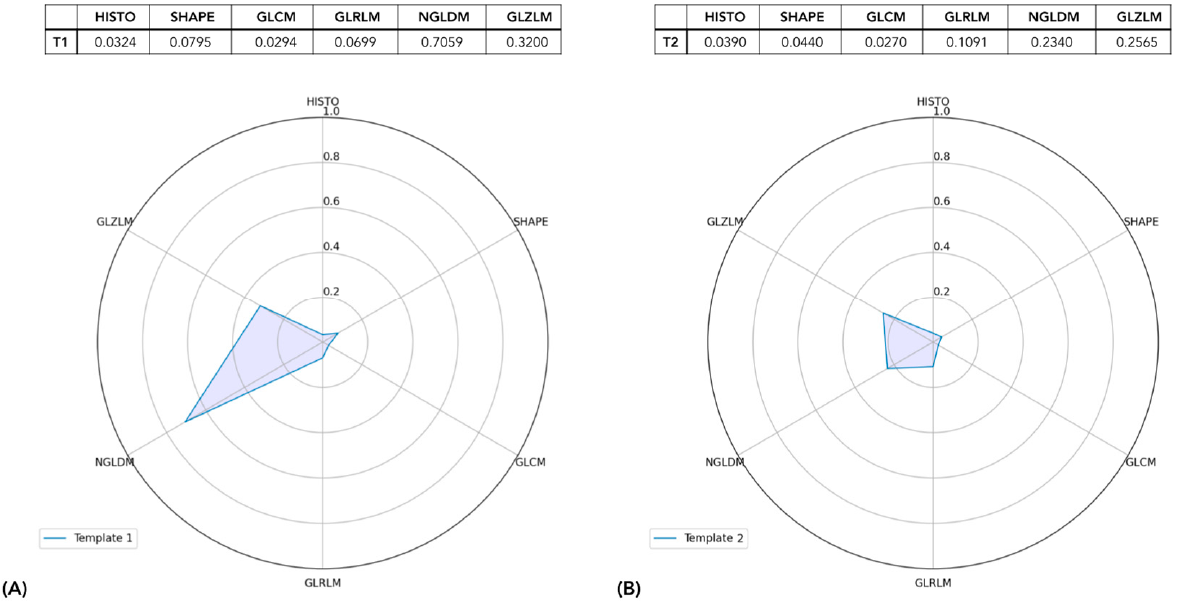
Figure 5. Mean radiomic profile of the two classes of lesions. In ( A ) the Class 1 radiomic template and in ( B ) the Class 2 radiomic template are displayed. The mean depth measure values are listed in the tables and graphically represented in the spider plots.